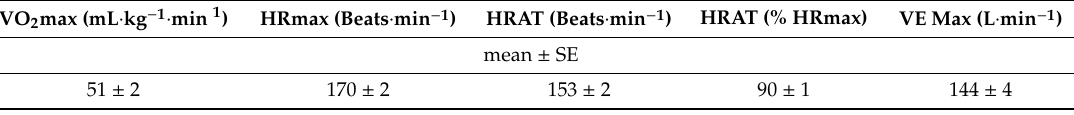
Table 1. Physiological variables measured during an incremental treadmill